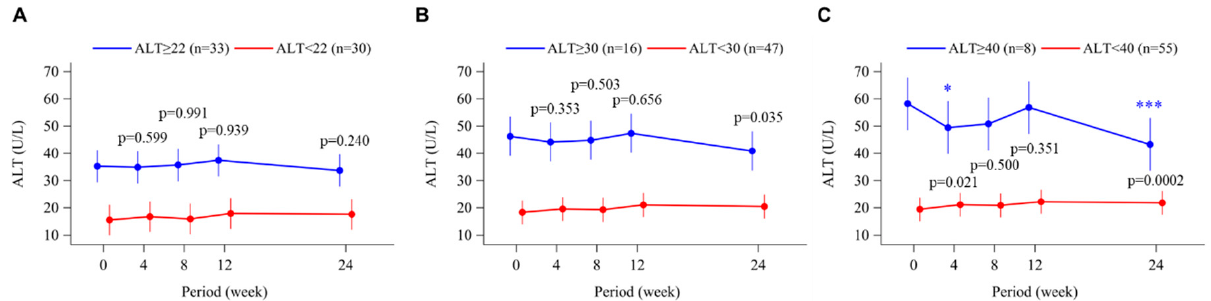
Figure 6. Time course of changes in alanine aminotransferase (ALT) from baseline to week 24 in the topiroxostat-treated group. Patients were divided into groups according to baseline ALT level, above or below 22 U/L (median; A ), 30 U/L ( B ), and 40 U/L (upper limit of normal; C ). Points and bars represent the least-squares mean and 95% confidence interval values using a mixed-effects model with repeated measures adjusted for sex and age. p -values within each graph are for the between-group difference in change from baseline. * p < 0.05 and *** p < 0.001 for change from baseline in the ALT-high